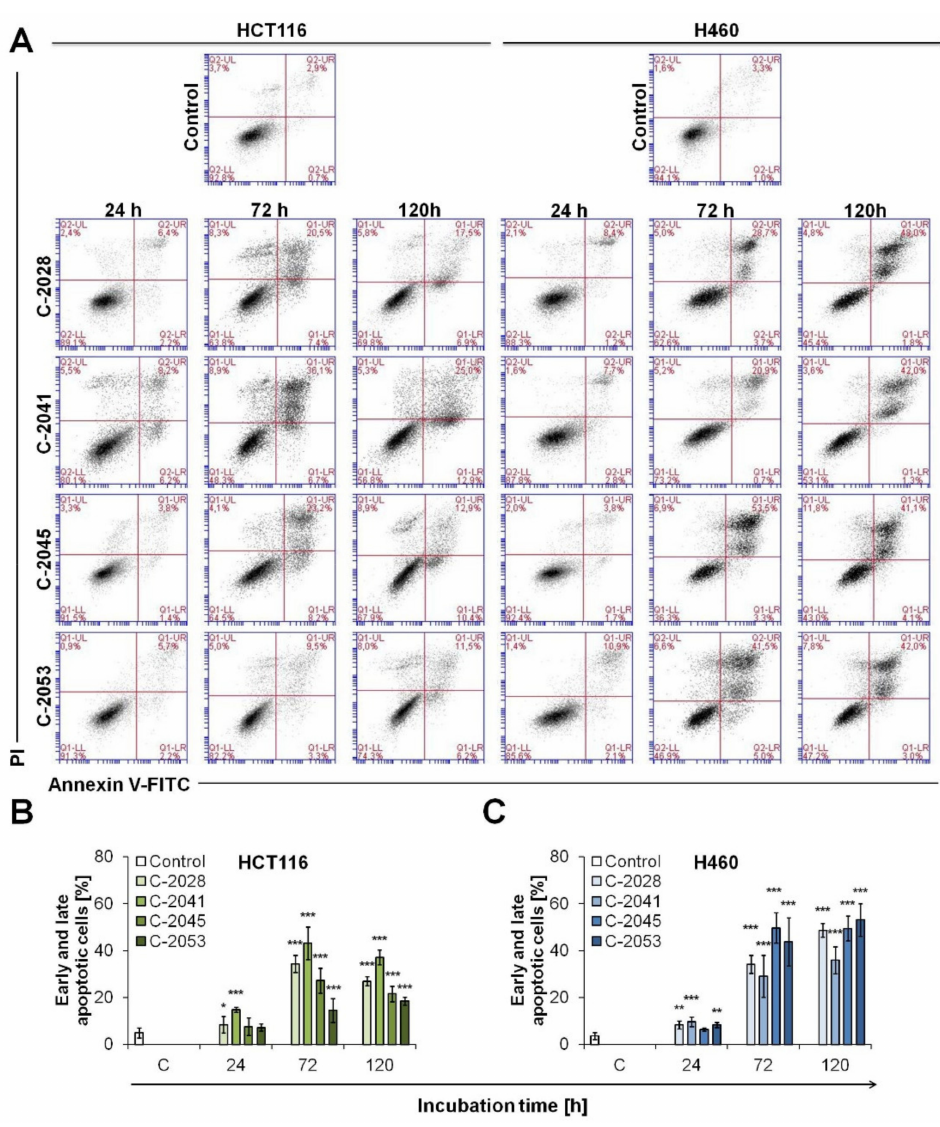
Figure 7. Phosphatidylserine externalization and membrane disruption in HCT116 and H460 cells treated with UAs. Cells were exposed to 0.04, 0.05, 0.4 and 0.2 µ M of C-2028, C-2041, C-2045 and C-2053 compounds, respectively, stained with annexin V–fluorescein isothiocyanate (FITC) and propidium iodide (PI), and flow cytometry analysis was conducted. ( A ) Representative bivariate flow cytometry histograms of annexin V–FITC signal versus PI signal are shown. Bottom left quadrant represents living cells (annexin V negative, PI negative); bottom right quadrant represents early apoptotic cells (annexin V positive, PI negative); top right quadrant represents late apoptotic cells (annexin V positive, PI positive); top left quadrant represents primary necrotic cells (annexin V nega- tive, PI positive). The cytograms shown are representative of at least three independent experiments. ( B , C ) Bar graphs show quantified data, expressed as the percentages of cells stained with annexin V– FITC alone or with PI—sum of early and late apoptotic cells established for HCT116 cell line ( B ) and H460 ( C ). Significantly different from the control at: * p < 0.05; ** p < 0.01; *** p < 0.001; ( n ≥